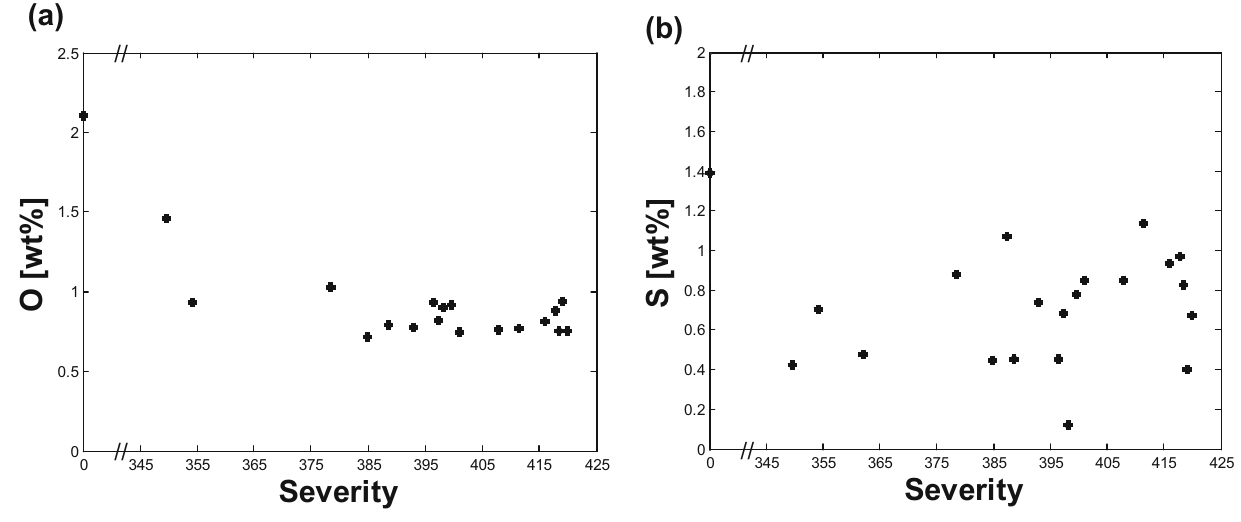
Fig. 6 Heteroatom content as a function of severity a oxygen b